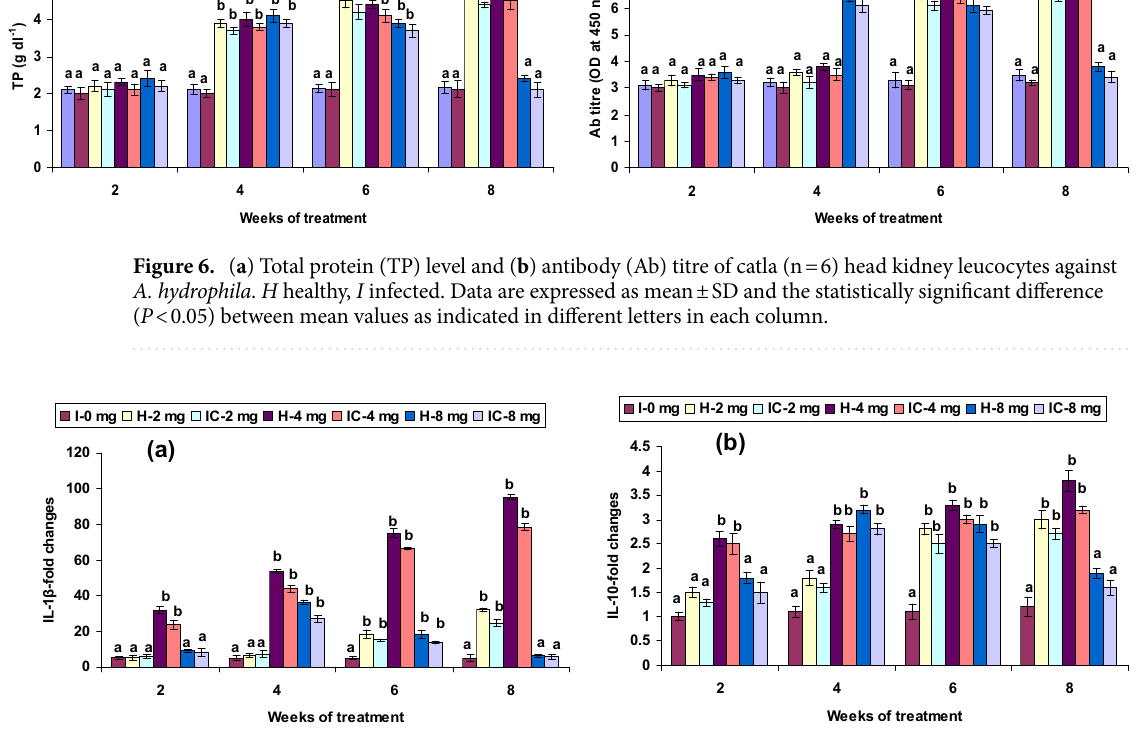
Figure 7. Expression pattern of ( a ) IL-1β and ( b ) IL-10 gene relative to β-actin in the head kidney of catla (n = 3) against A. hydrophila . H healthy, I infected. Values are expressed as mean ± SD and the statistical difference between means ( P < 0.05) indicated in different letters in each